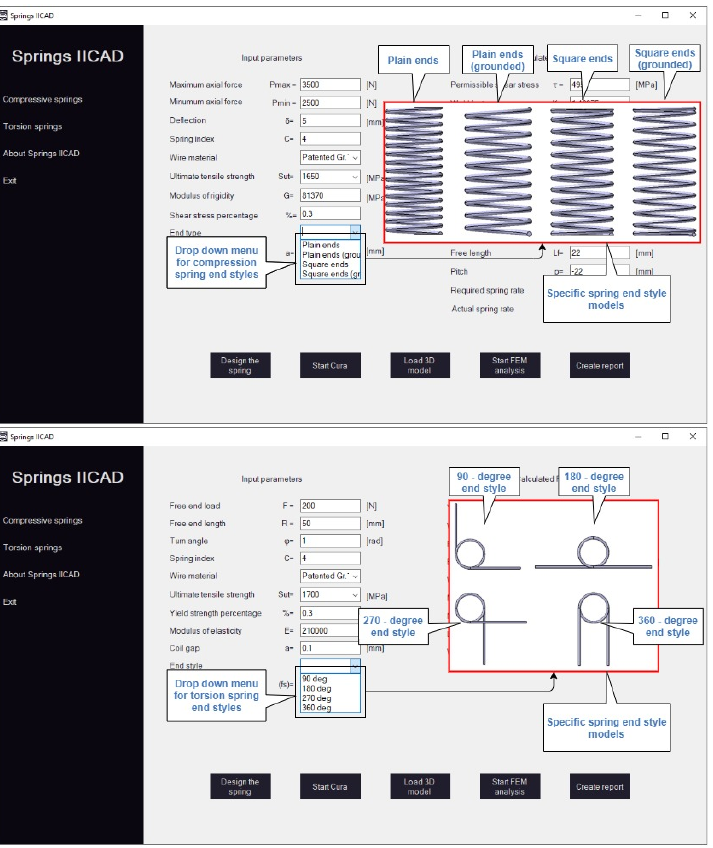
Figure 6. Possible spring model generation outputs based on the end styles (top to bottom: compression spring end styles and torsion spring end styles, respectively).